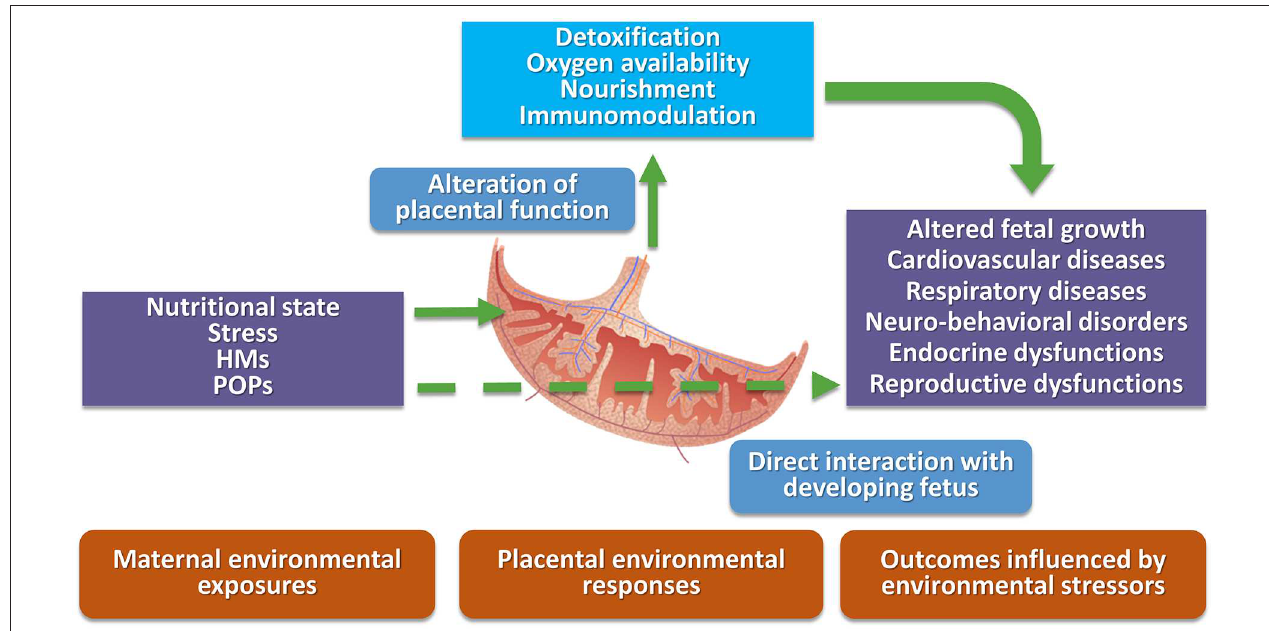
FIGURE 1 | Schematic representation of direct and indirect interactions among environmental stressors, placental domain, and possible negative health outcomes. HMs, heavy metals; POPs, persistent organic